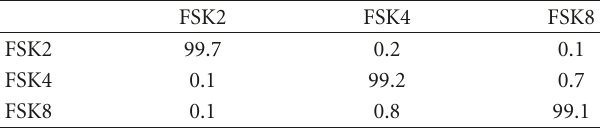
Table 3: Confusion Matrix at SNR = 3 d B.